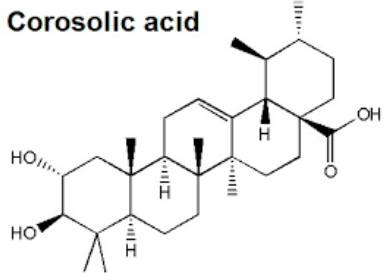
Scheme 1. Chemical structure of corosolic